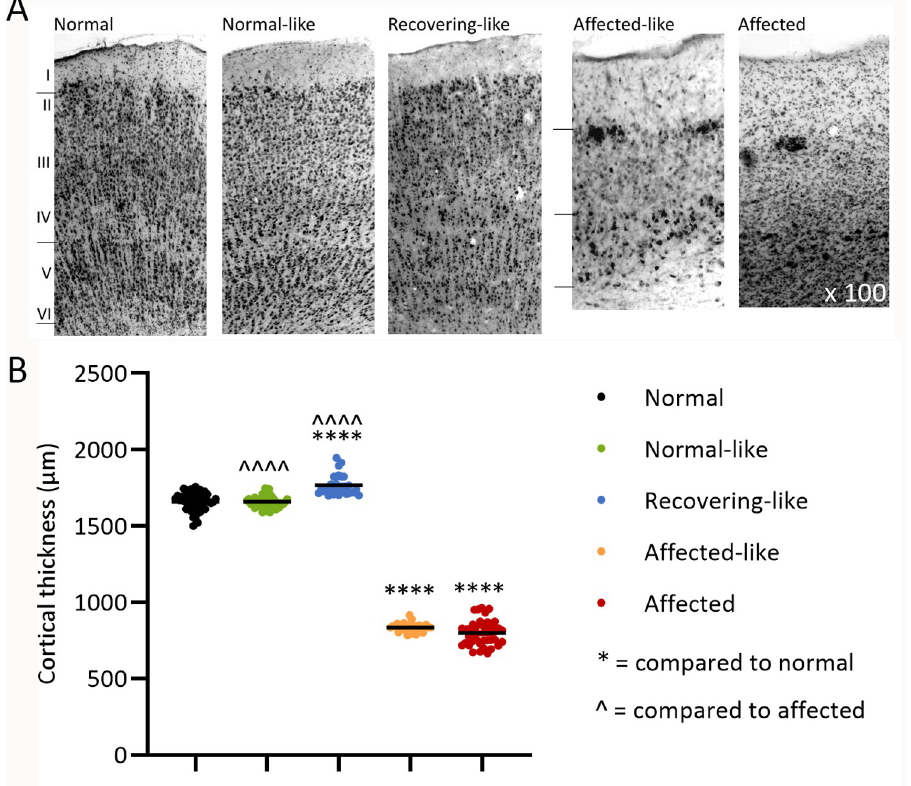
Fig 4. Nissl staining of the occipital cortex. A) Representative images of normal-like and recovering-like chimeras show a typical normal cortical layer structure with no indication of neurodegeneration. Extensive neuronal loss and less distinct cortical layer boundaries are evident in affected-like chimeras with densely packed cellular aggregates visible within upper cortical layers. See S1 Fig for all images. B) Thickness measurements were made through the occipital cortex of chimeric sheep and compared to adult normal (black) and affected (red) controls. The five recovering-like (blue) and normal-like (green) chimeras are within the normal range whereas affected-like (orange) chimeras have cortical thickness measurements equivalent to affected controls. Note: n � 50 measurements. ���� and ˆˆˆˆˆ indicate P < 0.0001.